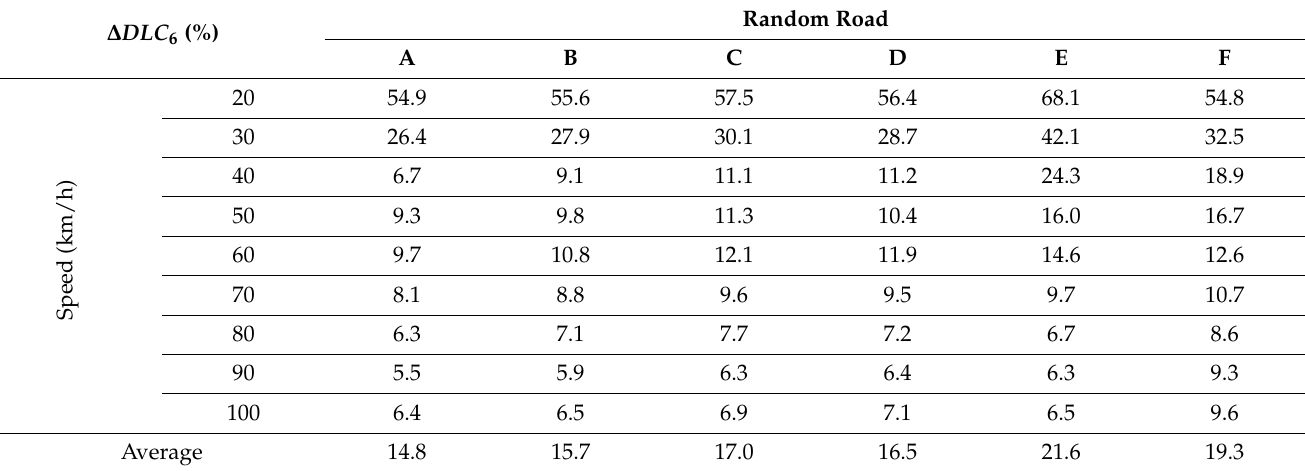
Table 6. The extent of the reduction of ∆ DLC (%): 6th